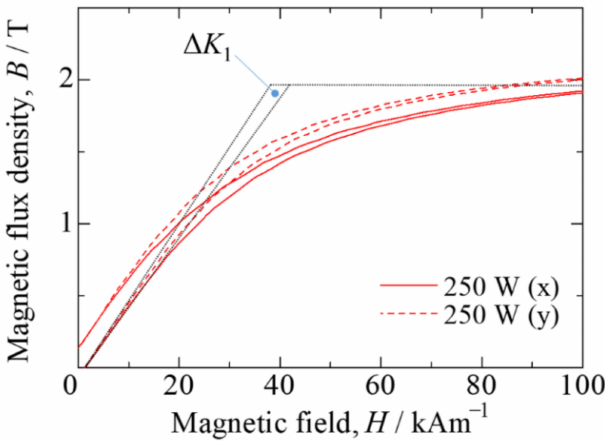
Figure A1. Approximately calculated anisotropy